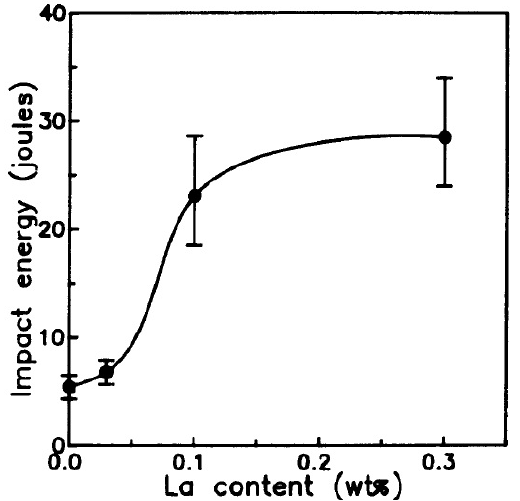
Figure 9. Effect of La on the impact energy of the alloy doped with 150 ppm of P [67]. Reproduced with permission from Hong et al., Metallurgical Transactions A; published by Springer, 1991.